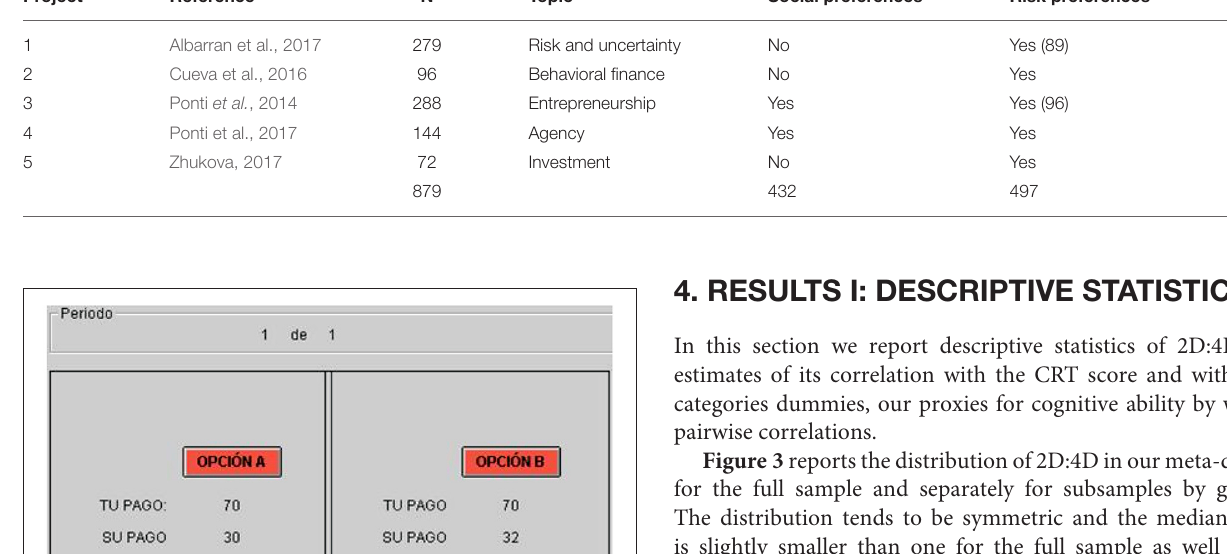
TABLE 1 | Summary of experimental projects in the meta-dataset. Project